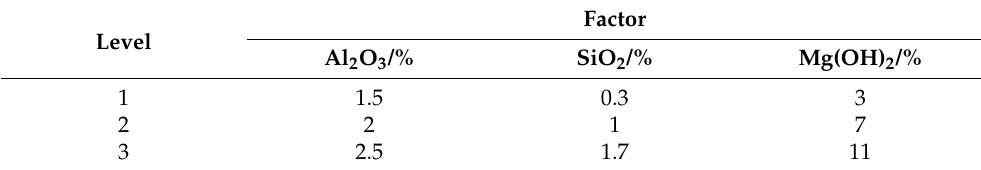
Table 1. Orthogonal experimental factor levels.